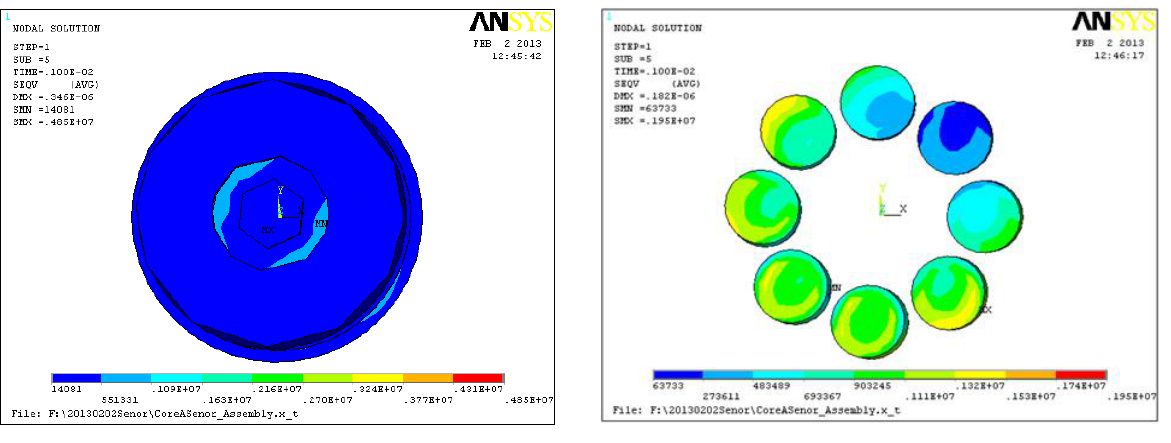
Figure 6. The strain cloud of six-DOF accelerometer’s core parts and quartz crystal chip groups under the composite